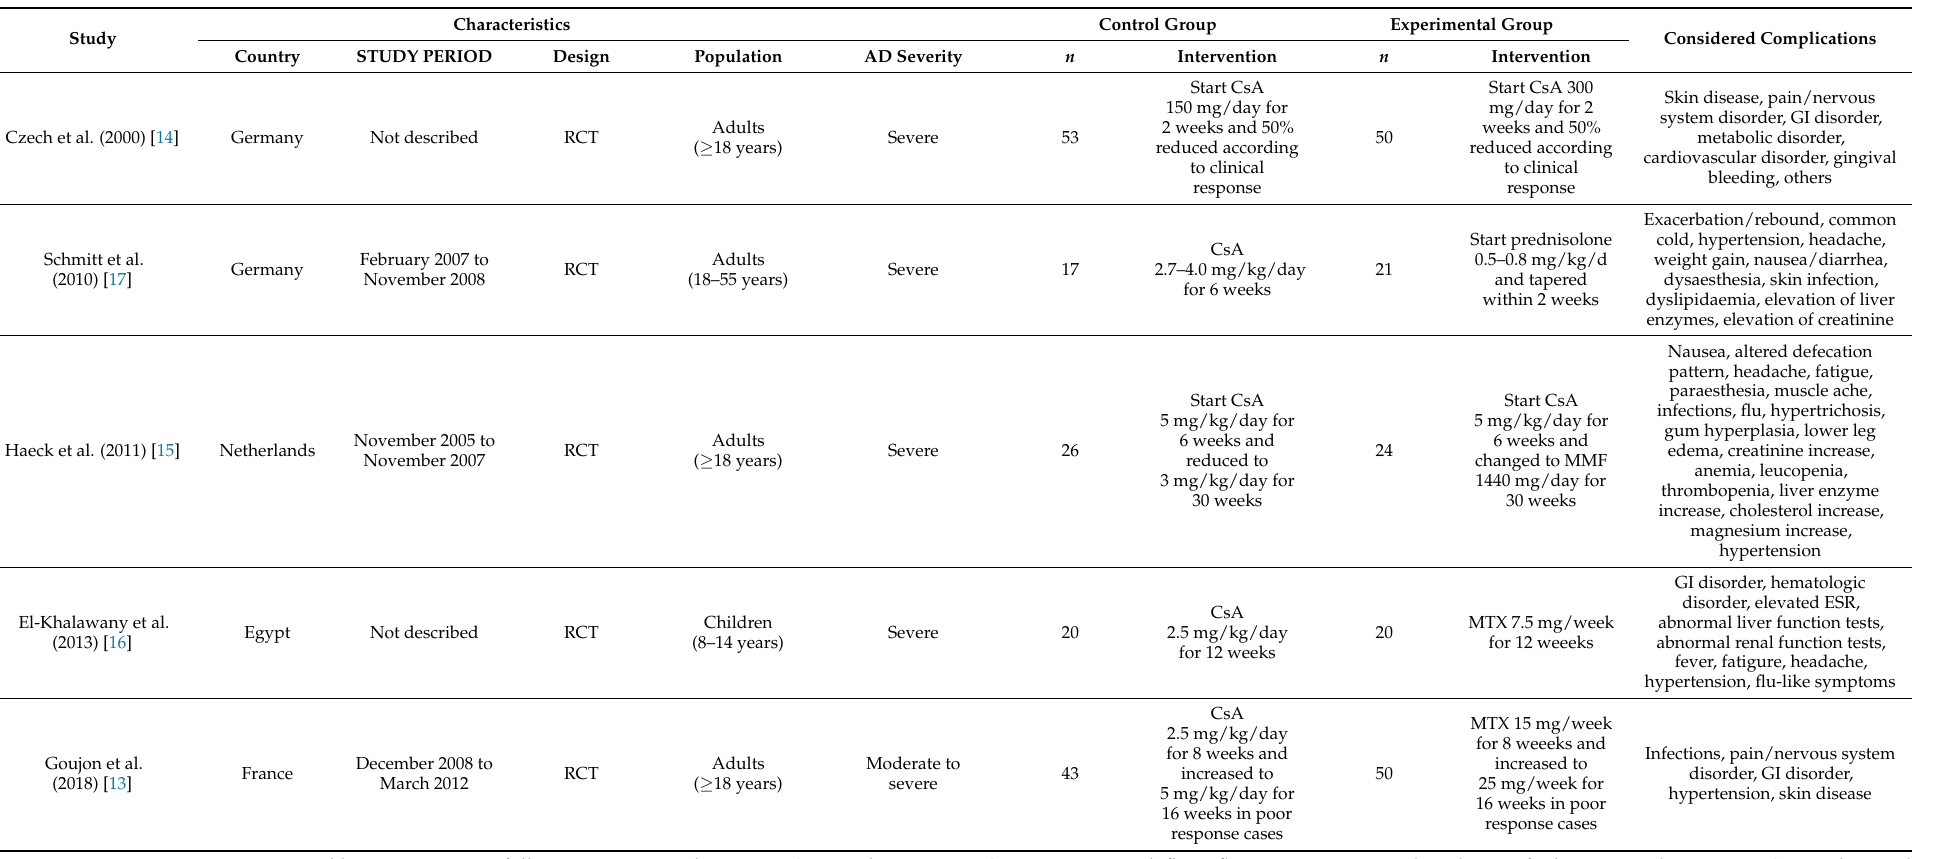
Table 1. Characteristics of studies included in the